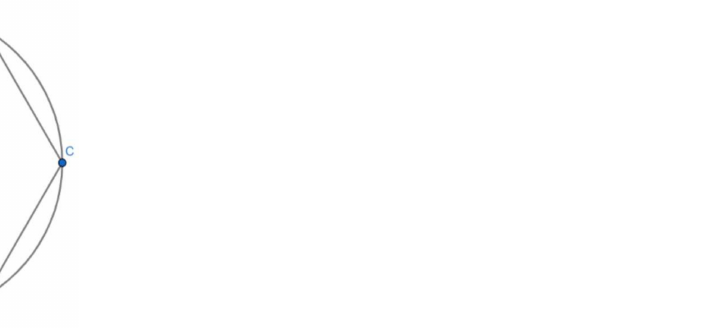
Figure 1. The triangle of Zenodorus and Hypsicles, also reconfirmed by Pappus, is capitalizable as a constructive axis of the regular convex polygon inscribed in the GAIN